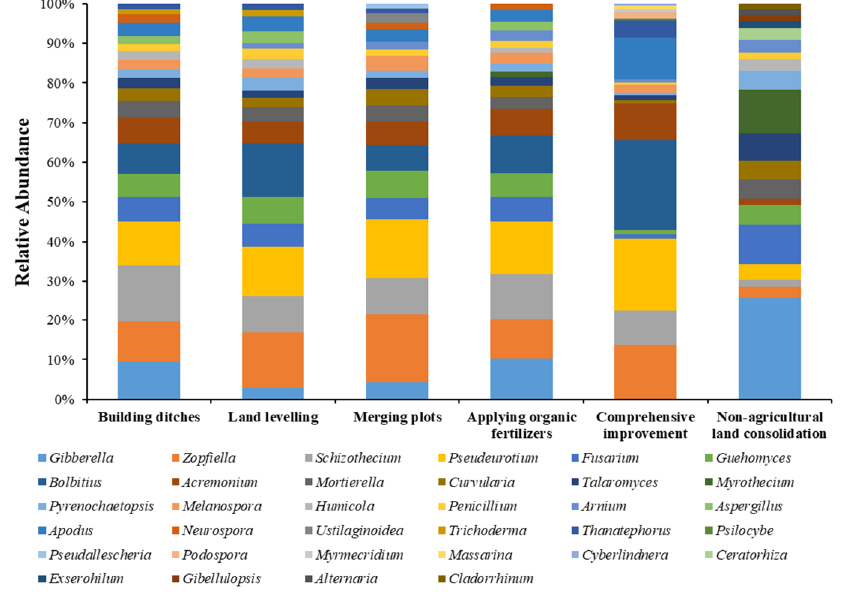
Figure 6. Relative abundance of dominant fungal genera in all soil sample groups in the study area.